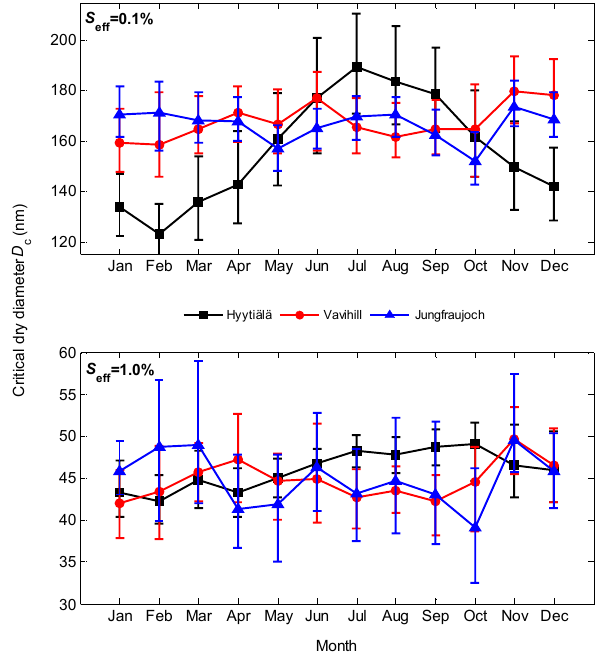
Figure 7. Monthly median D c at the S eff of 0.1% (upper) and 1.0% (lower) for three long-term measurement locations. Error bars are 25th and 75th percentiles.